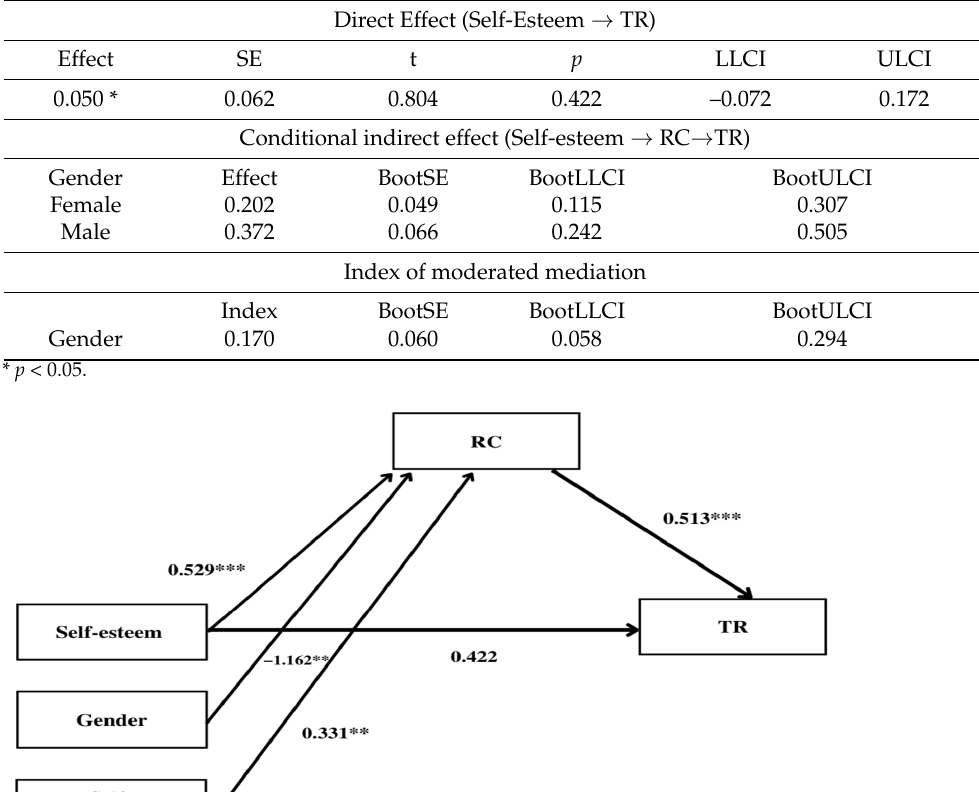
Table 5. The conditional direct and indirect effects of self-esteem on TR.